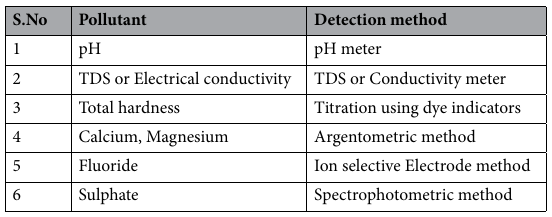
Table 1. Laboratory test used for the detection of various